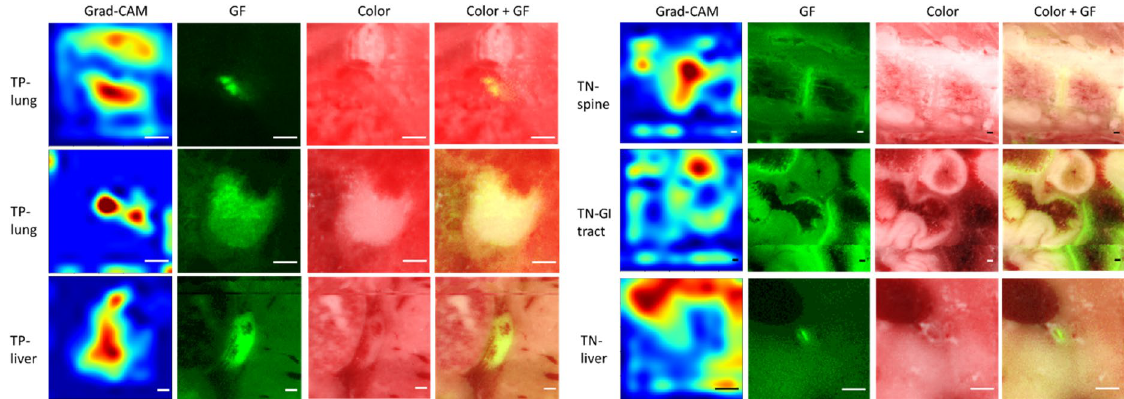
Figure 8. Grad-CAM for TP and TN candidates. The first two TP candidates are from the lung, and the last TP candidate is from the liver. The TN candidates are from the spine, GI tract, and liver. Scale bar is 200